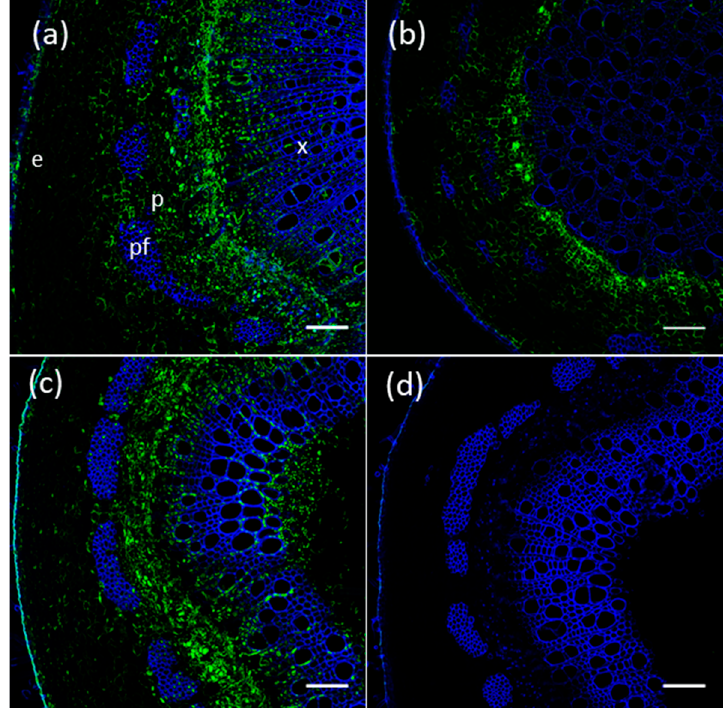
Figure 8. Immunolocalization of UGT72AZ1, UGT72AZ2, and UGT72A2 in transversal sections of 3-month-old WT poplar grown in the greenhouse. ( a ) UGT72AZ1 in the stem at 20 cm below the apex. ( b ) UGT72AZ2 in the root. ( c ) UGT72A2 in the stem at 10 cm below the apex. ( d ) Negative control in stem (no primary antibody). Alexa 488 signal corresponding to the UGT72 epitope is shown in green. Lignin autofluorescence is in blue. e, epidermis; p, phloem; pf, phloem fiber; x, xylem. Scale = 100 µm.